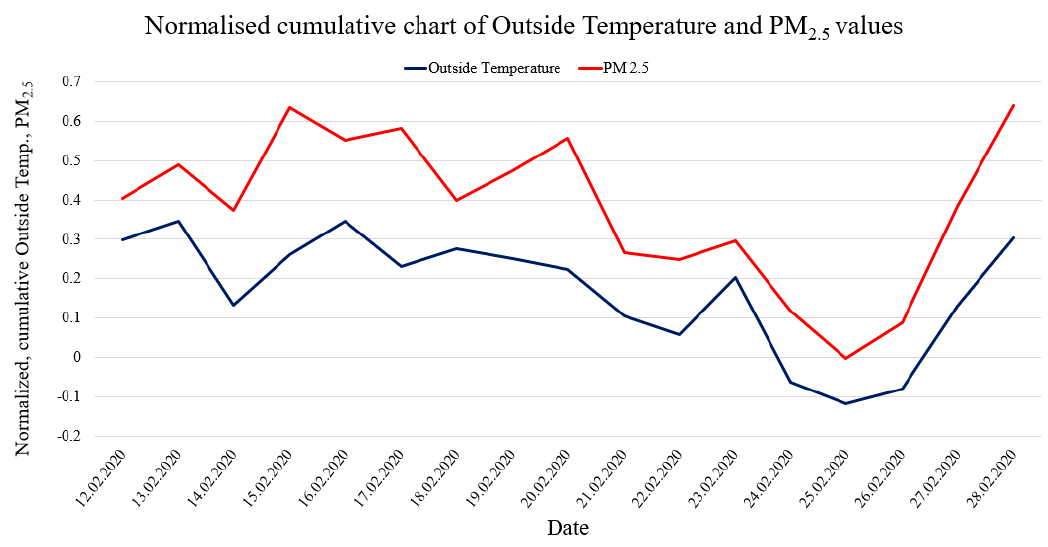
Figure 13. Comparison of standardized and cumulative values of the outside temperature and the PM 2.5 concentration.